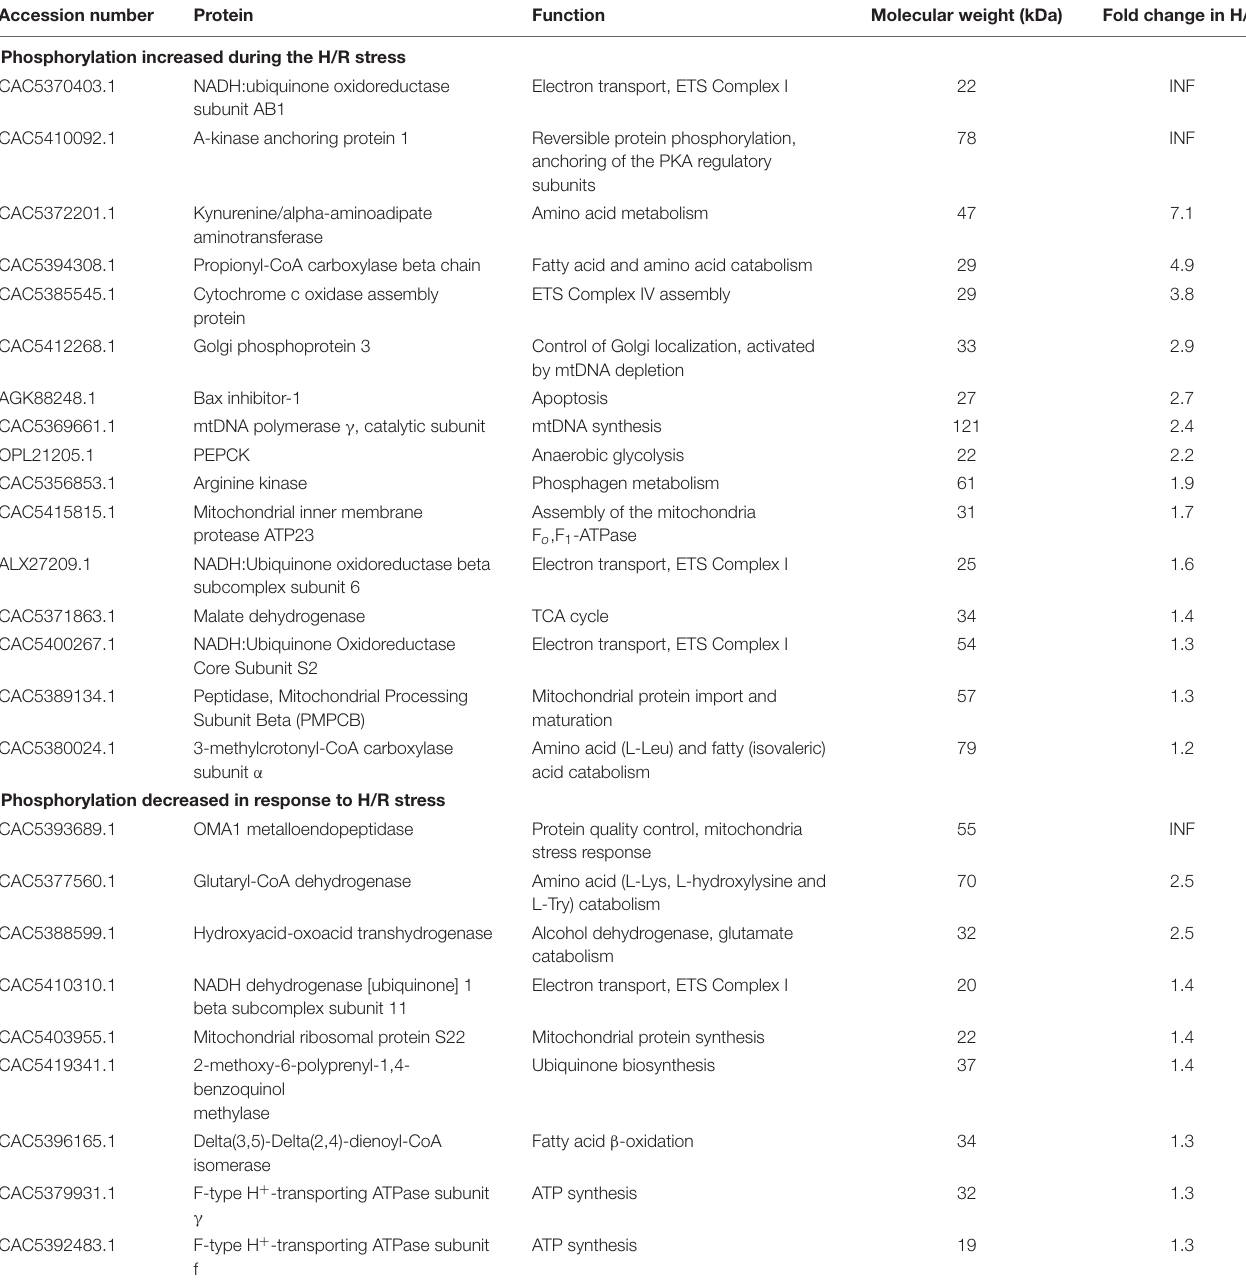
TABLE 2 | List of the mitochondrial phosphoproteins that significantly changed in abundance in response to the exposure of the isolated mitochondria of M. edulis to H/R stress in vitro according to a p -value-based Welch’s t -test ( p -value threshold 0.05) performed in Perseus. Protein Function Molecular weight